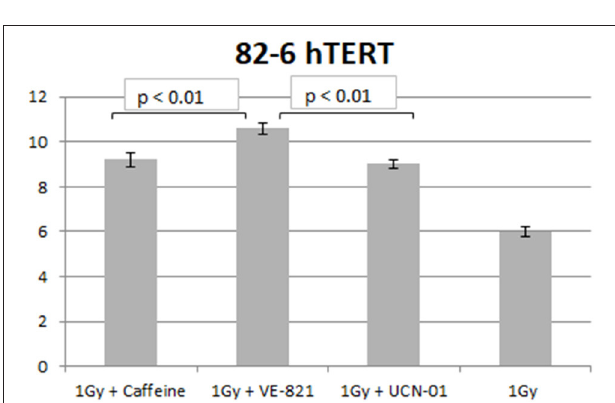
FIGURE 8 | Yield of chromatid breaks in the 82-6 hTERT cells pre-treated with Caffeine, VE-821, UCN-01 or left untreated following exposure to 1Gy (Mean ± SD based on three independent experiments; statistically significance criterion: p ≤ 0.05). VE-821 significantly increased the number of CB compared to Caffeine or UCN-01 ( p <